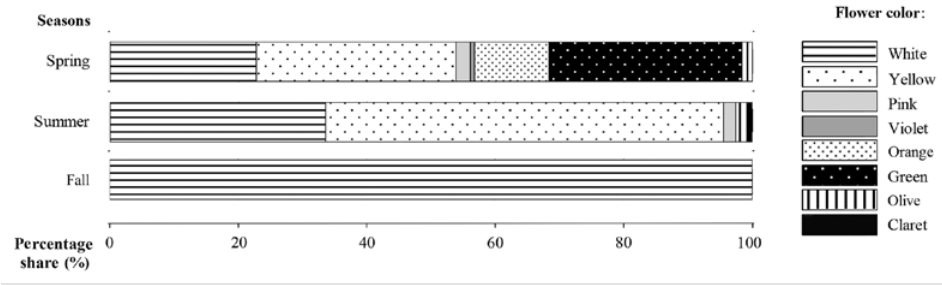
Fig. 6 Distribution of flower colors in the different vegetation seasons.